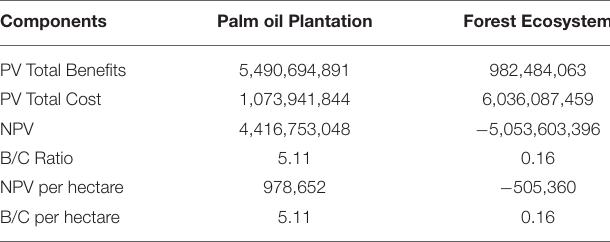
TABLE 7 | Results of the comparison for cost-benefit of socio-economic feasibility for palm oil plantation and forest ecosystem protection (in thousands IDR). Components